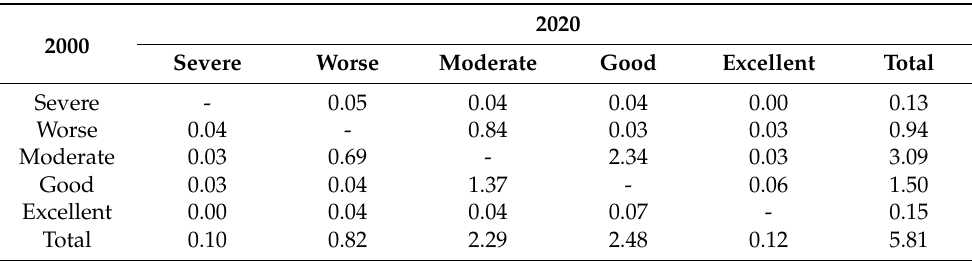
Table 6. Transfer matrix of different ecological quality level areas in the Pan-Third Pole region from 2000 to 2020 (Unit: million km 2 ).